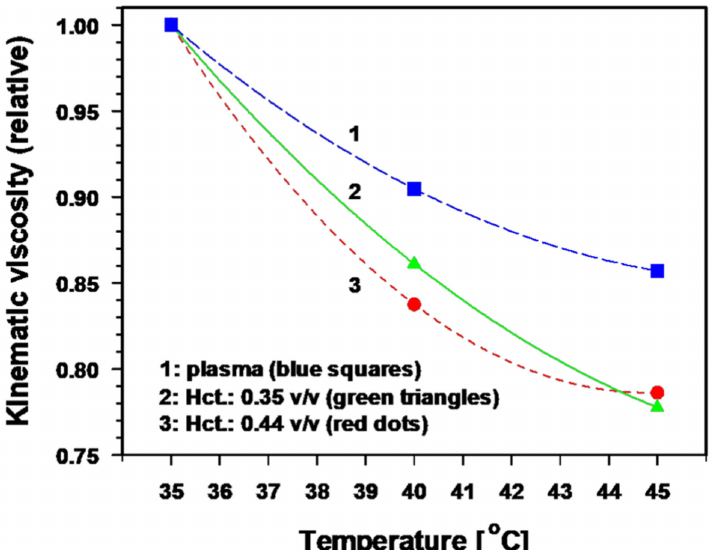
Figure 3. Relative kinematic blood viscosity and plasma viscosity as a function of temperature at physiological pH (based on data provided in [45]). Additional information: At 37 ◦ C, plasma viscosity is ≈ 1.3 cPoise (cP), and apparent viscosity of whole blood is ≈ 3.5 cP (shear rate: 150 s − 1